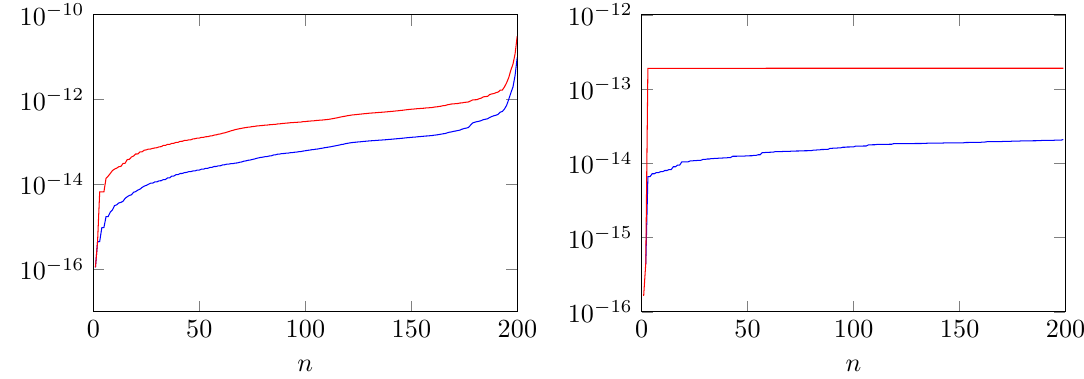
Figure 1: Biorthogonality and projection error, respectively left and right, for a unitary matrix U ∈ C 200×200 and same starting vectors. Two-term recurrence relation in blue and four-term recurrence relation in